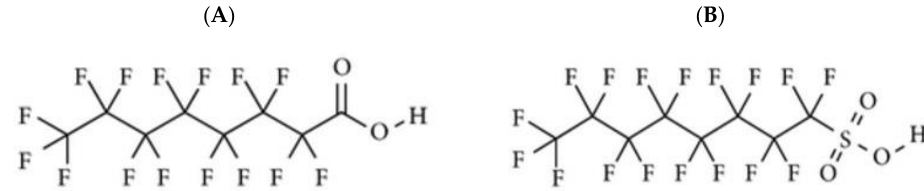
Figure 1. Chemical structures of perfluorooctanoic acid (PFOA) ( A ) and perfluorooctane sulfonic acid (PFOS) ( B ). Table 3. Chemical and physical properties of compounds that belong to the PFASs group, most frequently determined in the human blood serum.